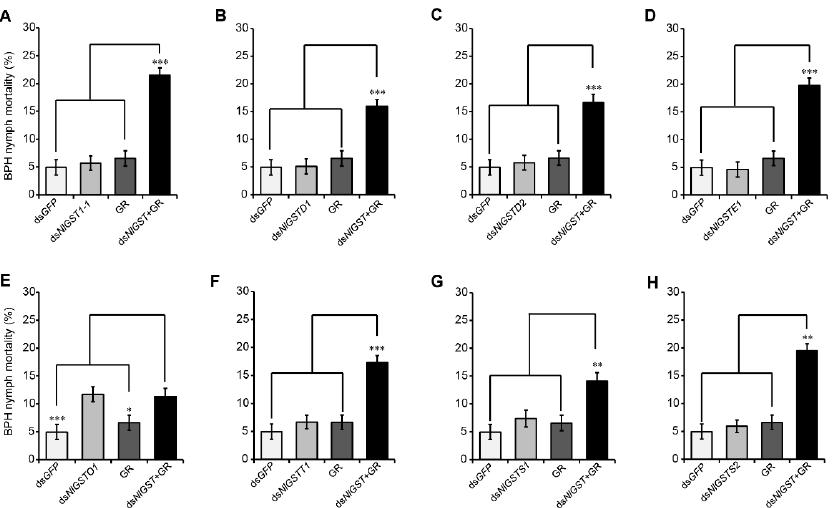
Figure 4. Sensitivity of dsRNA prefed BPH nymphs to gramine-containing diets. BPH nymphs